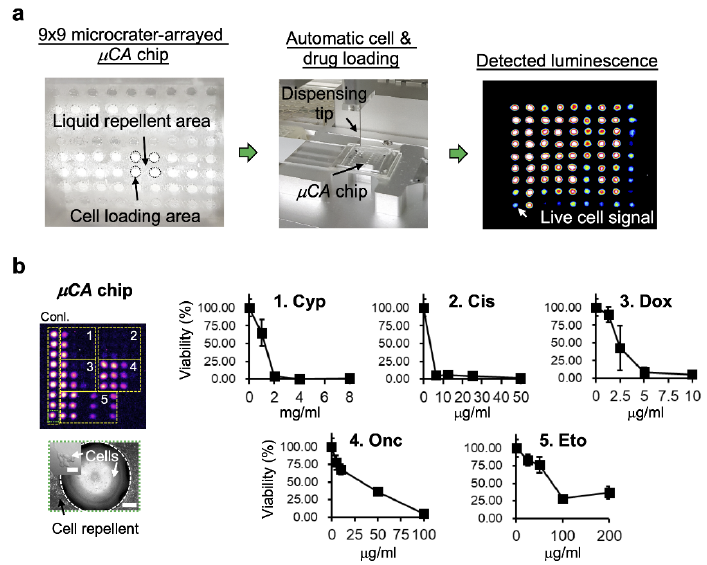
Figure 3. High-throughput drug screening by the microcrater-arrayed ( µ CA) chips: ( a ) Experimental procedure of the drug screening. ( b ) Demonstration for the high-throughput drug screening on SK- N-DZ cells by the µ CA chip. Live cells were evaluated based on the detection of chemiluminescence. Cyp: cyclophosphamide; Cis: cisplatin; Dox: doxorubicin; Onc: oncovin; Eto: etoposide. Scale bar is 170 µ m, and the insert bar is 50 µ m. Data represent the mean ± SD, n = 3 independent